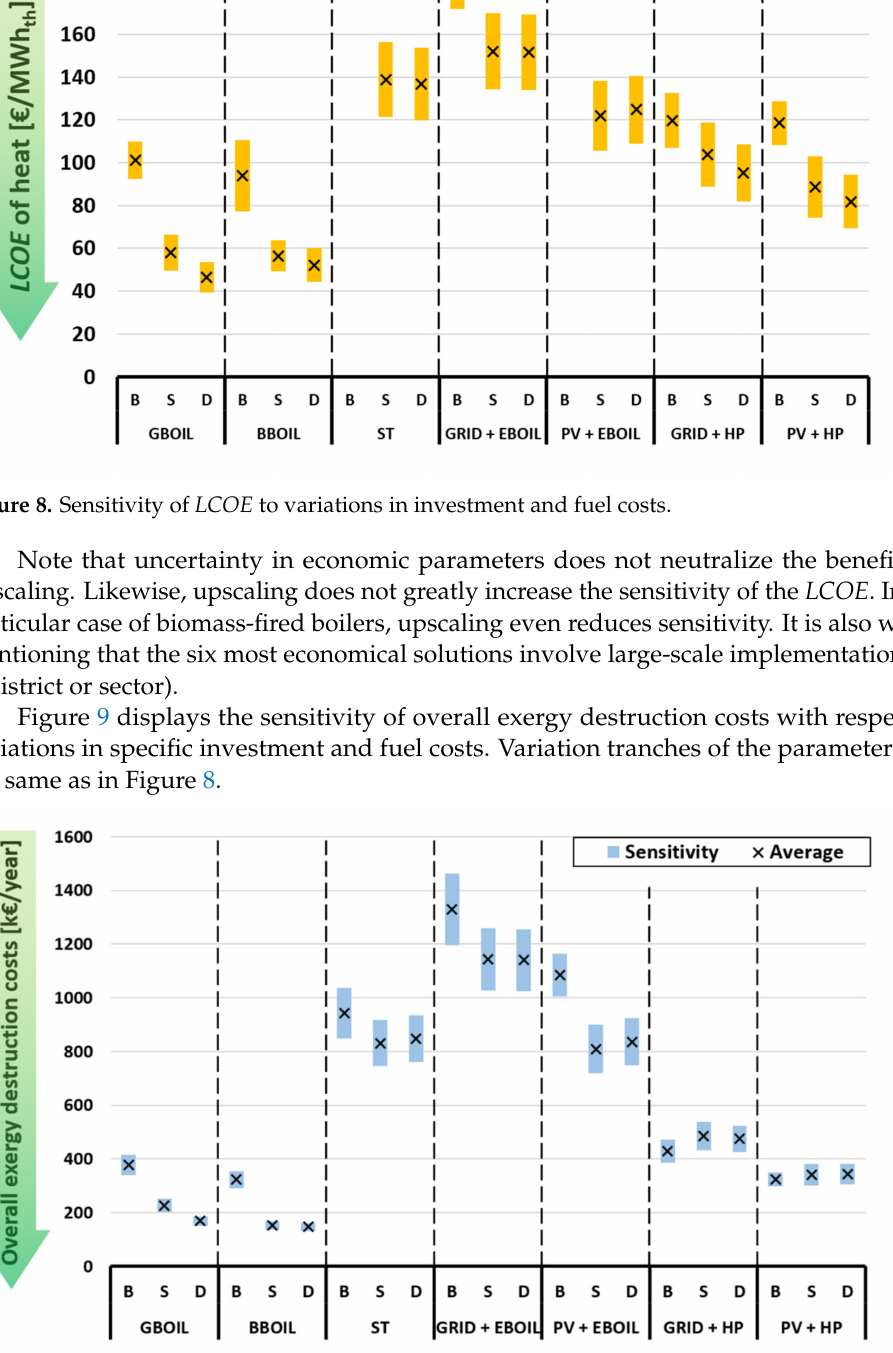
Figure 9. Sensitivity of exergy destruction costs to variations in investment and fuel